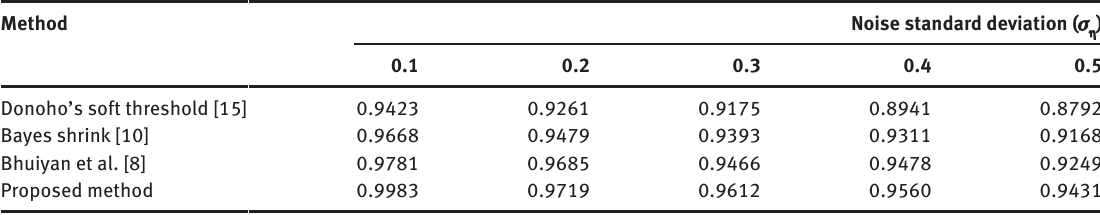
Table 2: Comparison of SSIM Performance for MR Images.